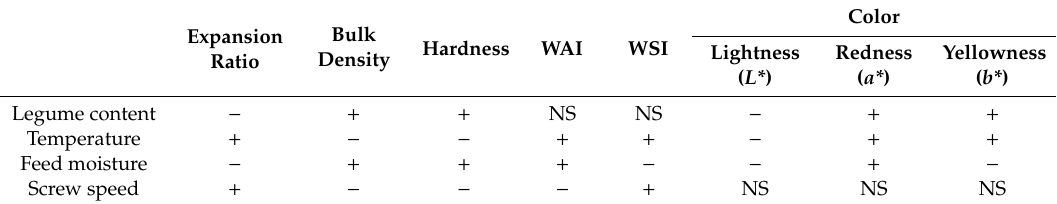
Table 2. E ff ect (positive / negative) of the increase in the main processing parameters of extrusion cooking on the physical-chemical characteristics of legume extrudates. Bulk Expansion Hardness Density Ratio